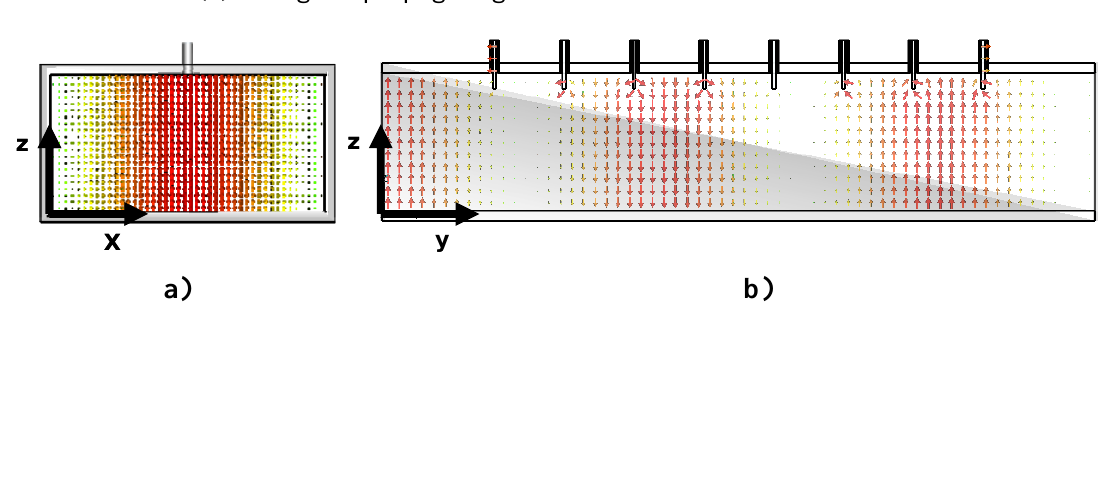
mode at the waveguide. (a) Perpendicular 10